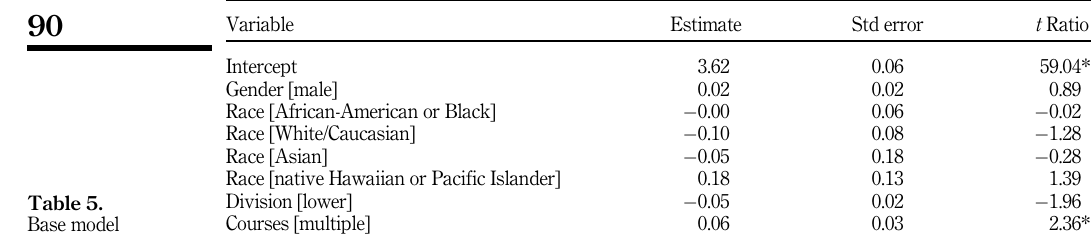
Table 5. Base model